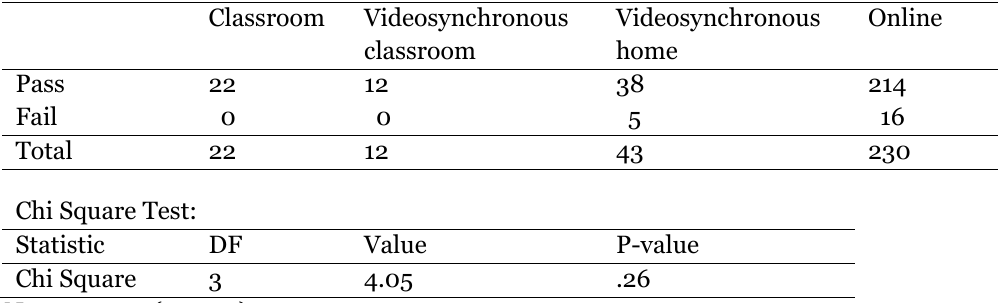
Chi Square Analysis on Association Between Pass Rates and Learning